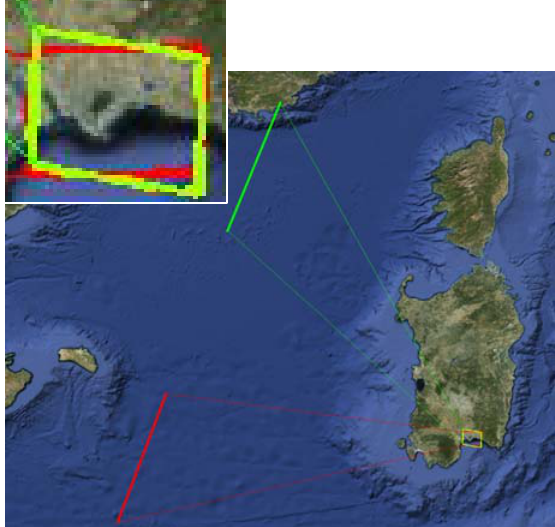
Figure 5. GPS survey (red) and DSBM (green)